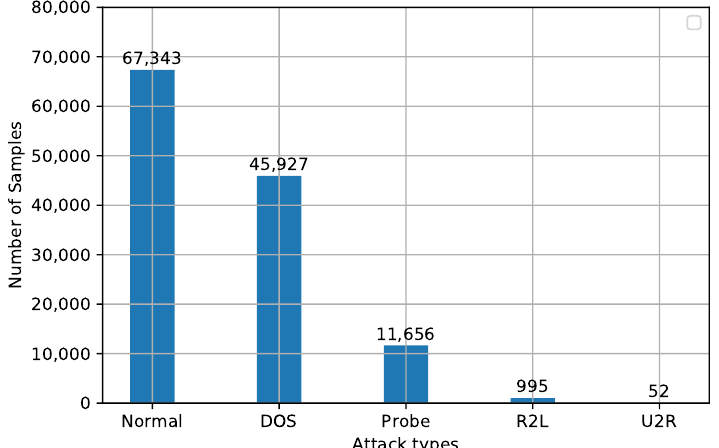
Figure 3. Categorized training set statistics show the number of samples in the four types of attacks and the normal samples in the training set.